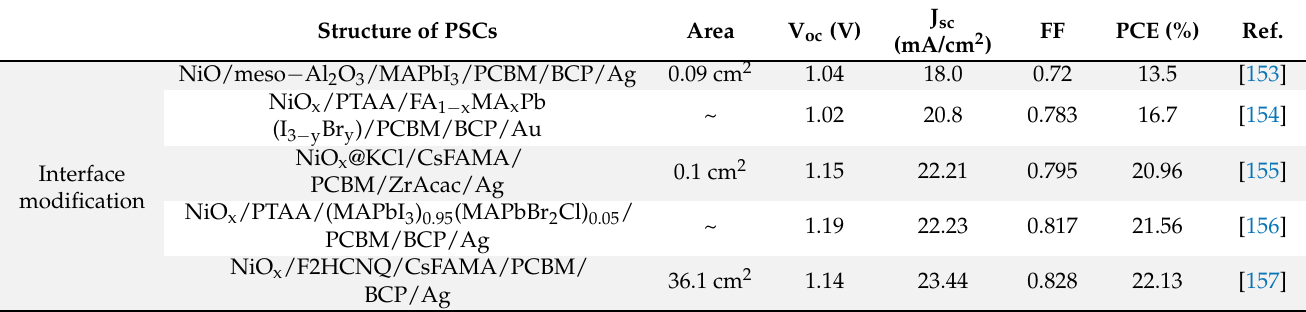
Table 14. Performances of several representative inverted PSCs on the basis of interfacial modified NiO x . Structure of PSCs Area V oc (V)